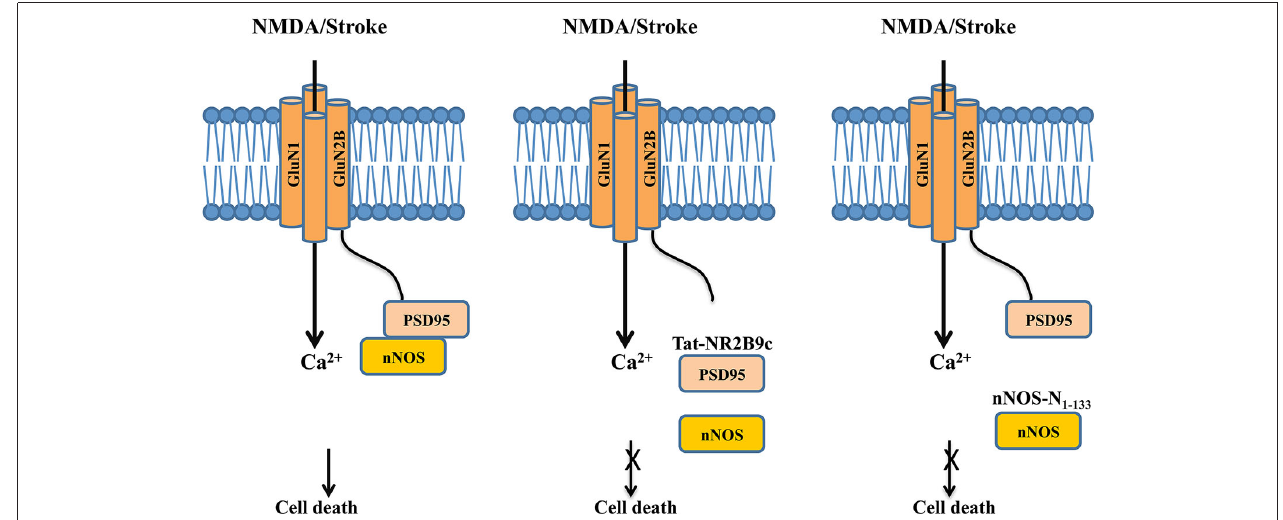
between PSD-95 and GluN2B, and hence dissociates PSD-95 and nNOS from the NMDAR complex. By doing so, the peptide reduces the NMDA-induced production of NO, and hence decreases NO-mediated excitotoxic/ischemic neuronal death. Right panel : Similarly, the interference peptide nNOS-N 1 − 133 disrupts the binding between PSD-95 and nNOS, thereby dissociating nNOS from the NMDAR complex. By reducing the NMDAR-mediated activation of nNOS, the peptide reduces NO production and hence excitotoxic/ischemic neuronal